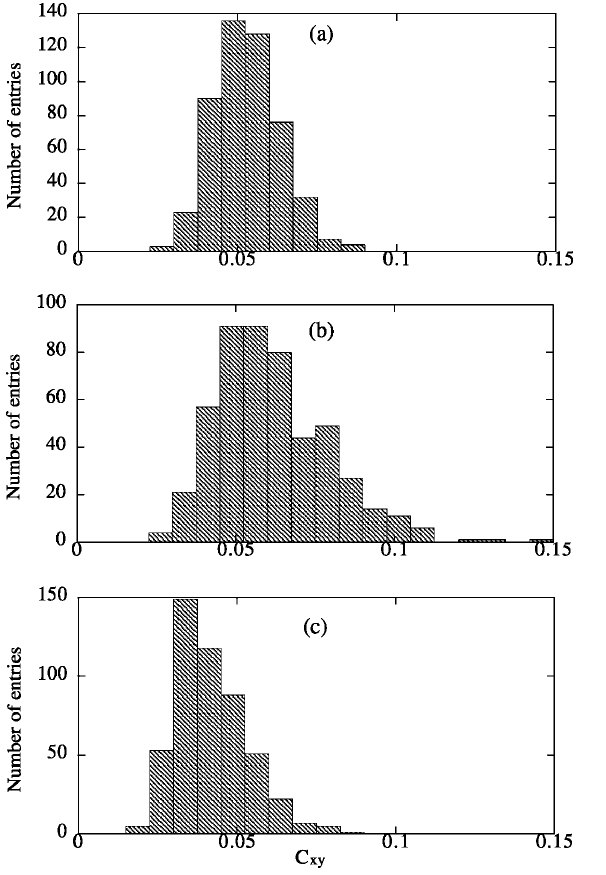
FIG. 5. Distribution of C (a) after COD correction, (b) after xy COD-dispersion correction, and (c) after coupling